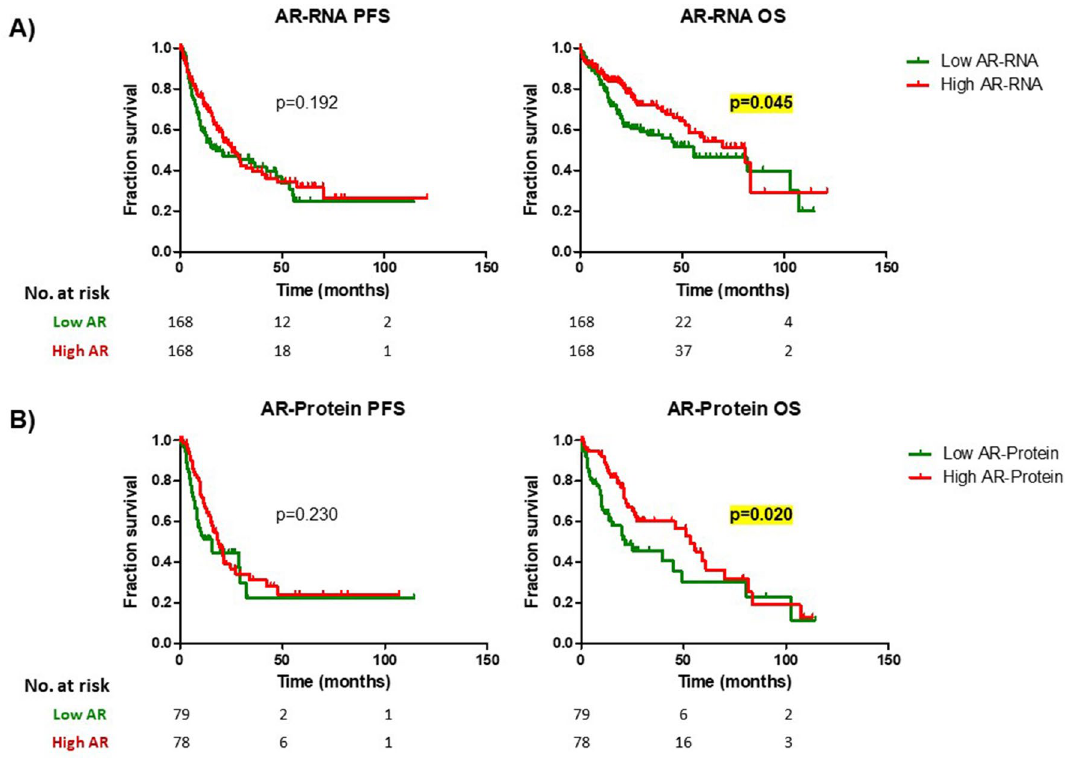
Figure 1. Survival analysis (progression free survival [PFS] and overall survival [OS]) in different androgen receptor expression groups at the level of mRNA ( A ) and protein ( B